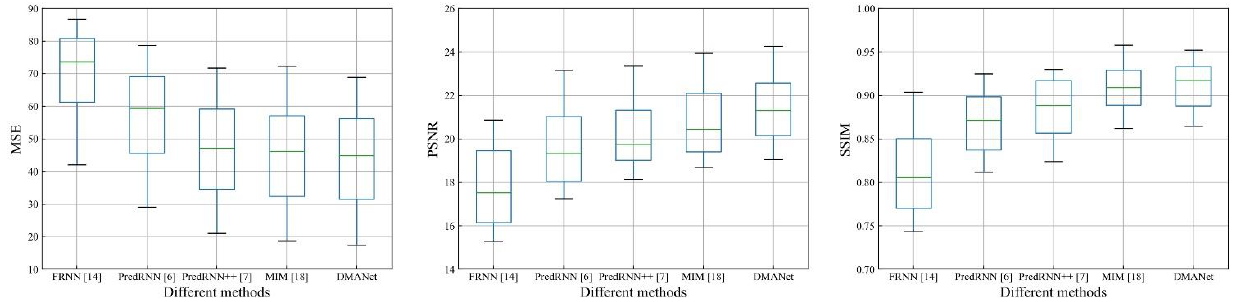
Figure 11. Whisker plot comparisons of the different models at the Moving MNIST [34].